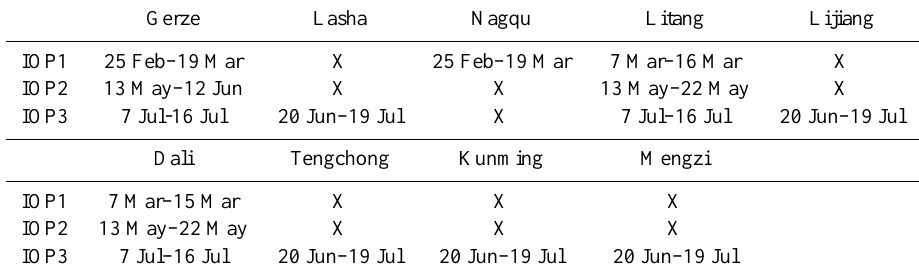
Table 1. Intensive observation dates of the three periods in 2008.